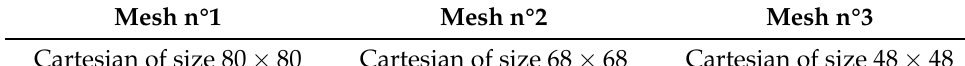
Table 1. Three regular meshes for training the VAE and resolving the Chorin numerical scheme